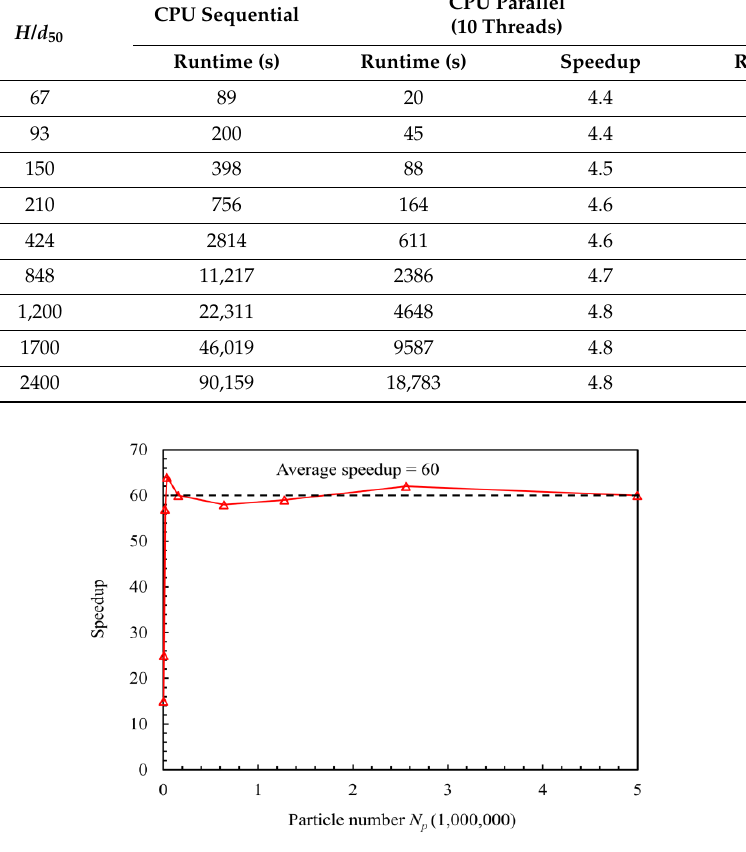
Figure 16. Runout profiles of sand pile with 1,280,000 particles.